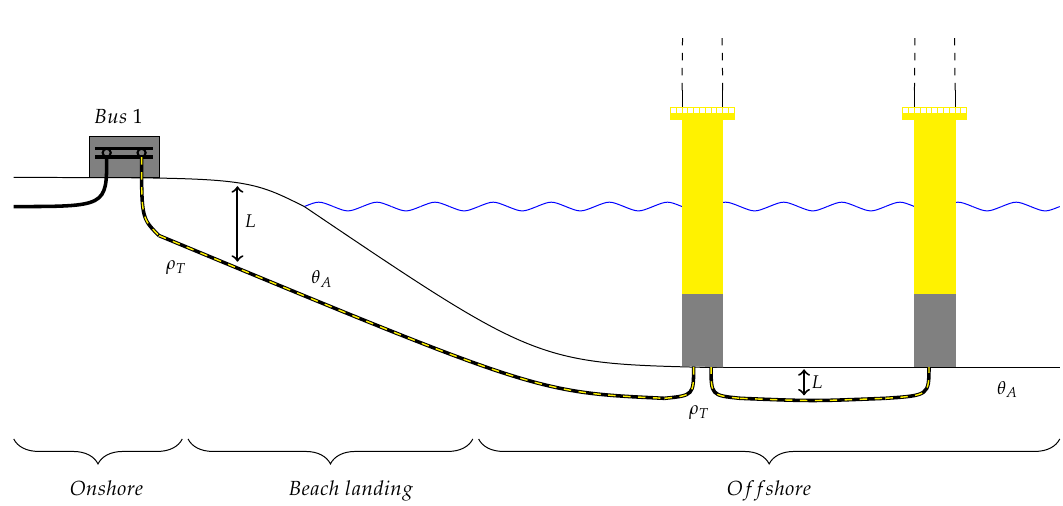
Figure 1. Submarine cable installations between onshore grid (Bus 1) and wind turbine generator (WTG) foundations illustrating surrounding conditions: onshore, at the beach landing and offshore.